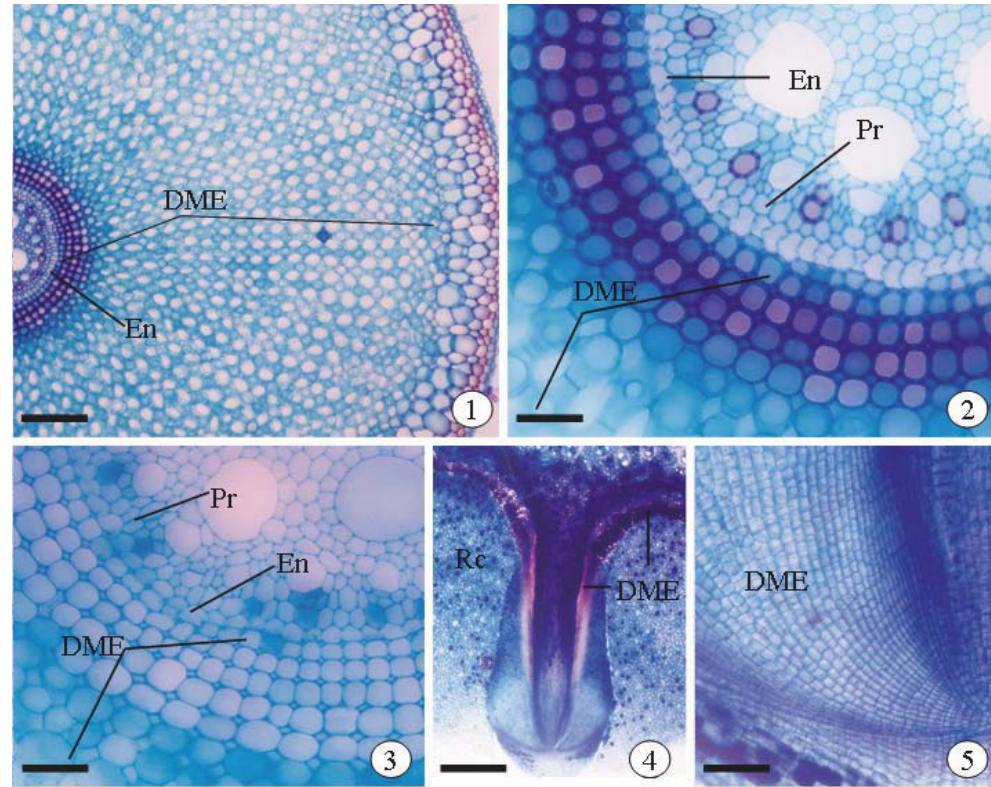
Fig. 1-5 – Cyperus papyrus . Root in transverse (1-3) and longitudinal (4 and 5) sections showing almost all the cortex with the placing of its radiate cells, originated by endodermal (En) activity, constituting the DME (Derivatives of Meristematic Endodermis). Note in Fig. 4, the tissue continuity between the root and the rhizome. The inner cortex is shown thickened at the root (Fig. 1, 2 and 4) and in the rhizome (Fig. 4). The pericycle (Pr) is uniseriate. Rc – rhizome cortex. The bars correspond respectively to: 400 µ m, 100 µ m, 100 µ m, 600 µ m and 40 µ